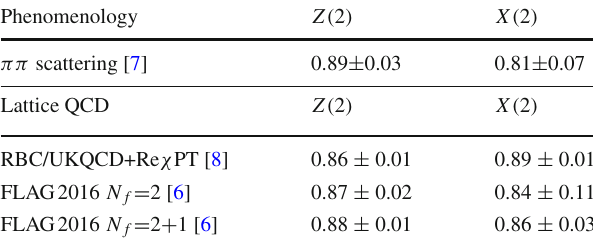
Table 1 Chosen results for the two flavor order parameters